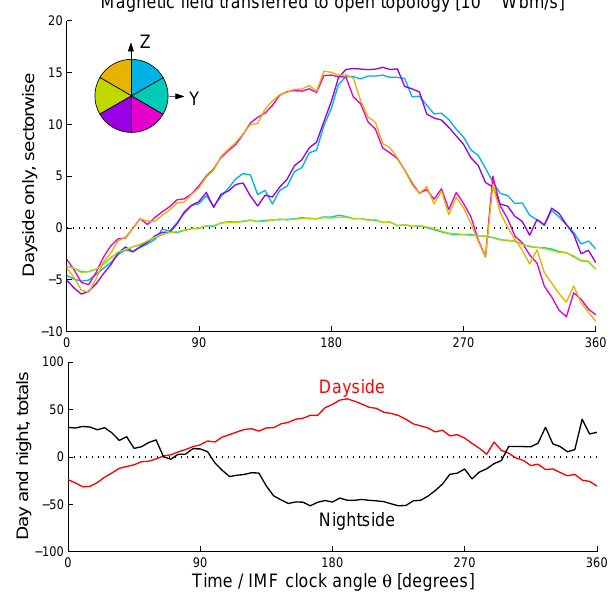
Fig. 4. The amount of magnetic field transferred from topologically closed to other regions. In the top panel, the transfer is calculated on the dayside ( X> 0) in six sectors; the colour-coding of the sectors is illustrated by a small front view of the magnetopause. In the lower panel the total amount of opening magnetic field in the dayside and the nightside are